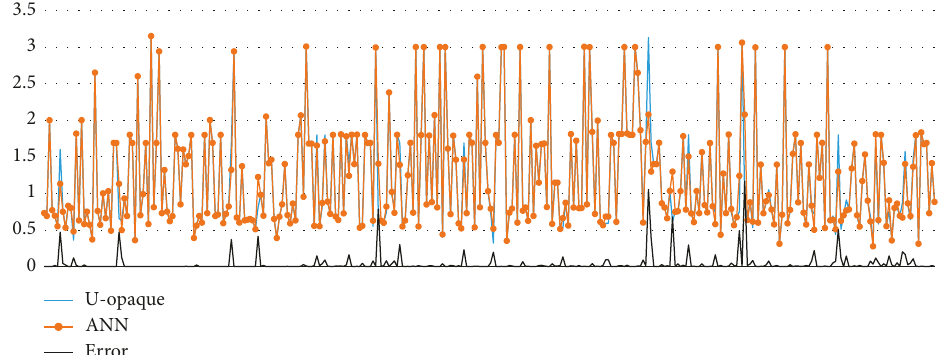
Figure 14: Comparison between measured and ANN predicted U-opaque values for all building types.